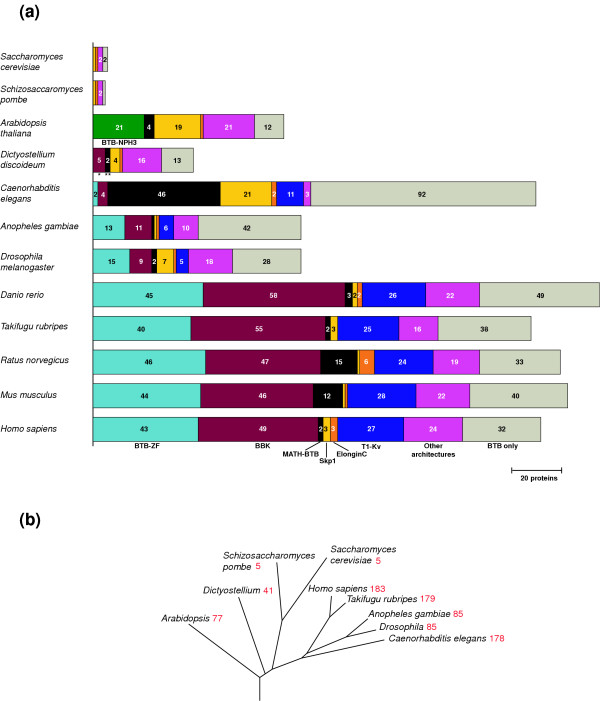
Distribution of BTB proteins in eukarytoic genomes. (a) Representation of BTB proteins in selected sequenced genomes. Twelve of the seventeen genomes we searched are represented, showing each type of BTB protein architecture as bar segments. Data for Apis mellifera, Canis familiaris, Gallus gallus, Pan troglodytes and Xenopus tropicalis are available at [35]. Several lineage-specific expansions are evident: BTB-ZF and BBK proteins in the vertebrates; the MATH-BTB proteins in the worm; the BTB-NPH3 proteins in the plant; the Skp1 proteins in the plant and worm; and the T1 proteins in worm and vertebrates. In the Dictyostellium discoideum genome, a single star indicates five BTB-kelch proteins that do not contain the BACK domain, and a double star indicates two MATH-BTB proteins that also contain ankyrin repeats. (b) Phylogenetic relationship of analyzed genomes. Adapted from [39]. The total number of BTB proteins is shown above each genome.